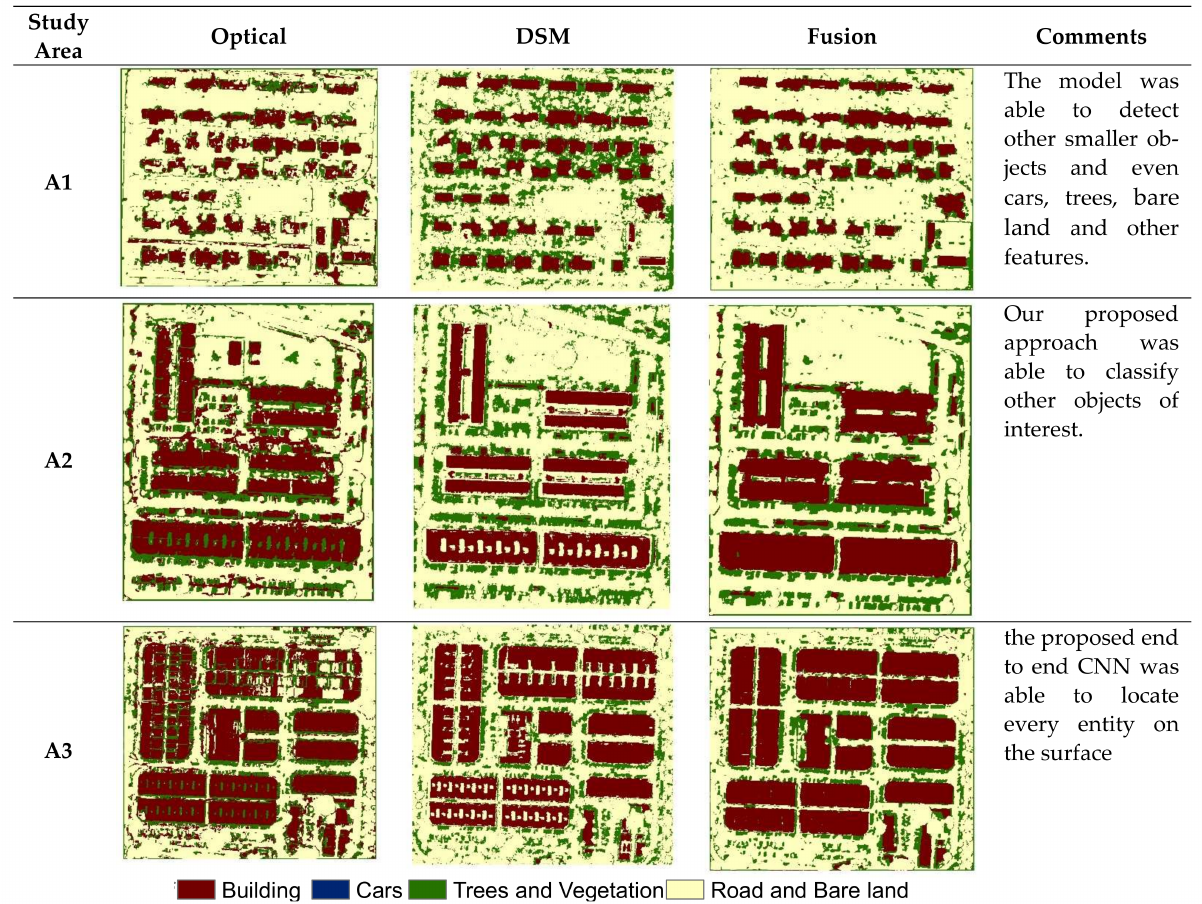
Figure 5. Classification outputs of building extraction displaying other detected features from end-to-end CNN